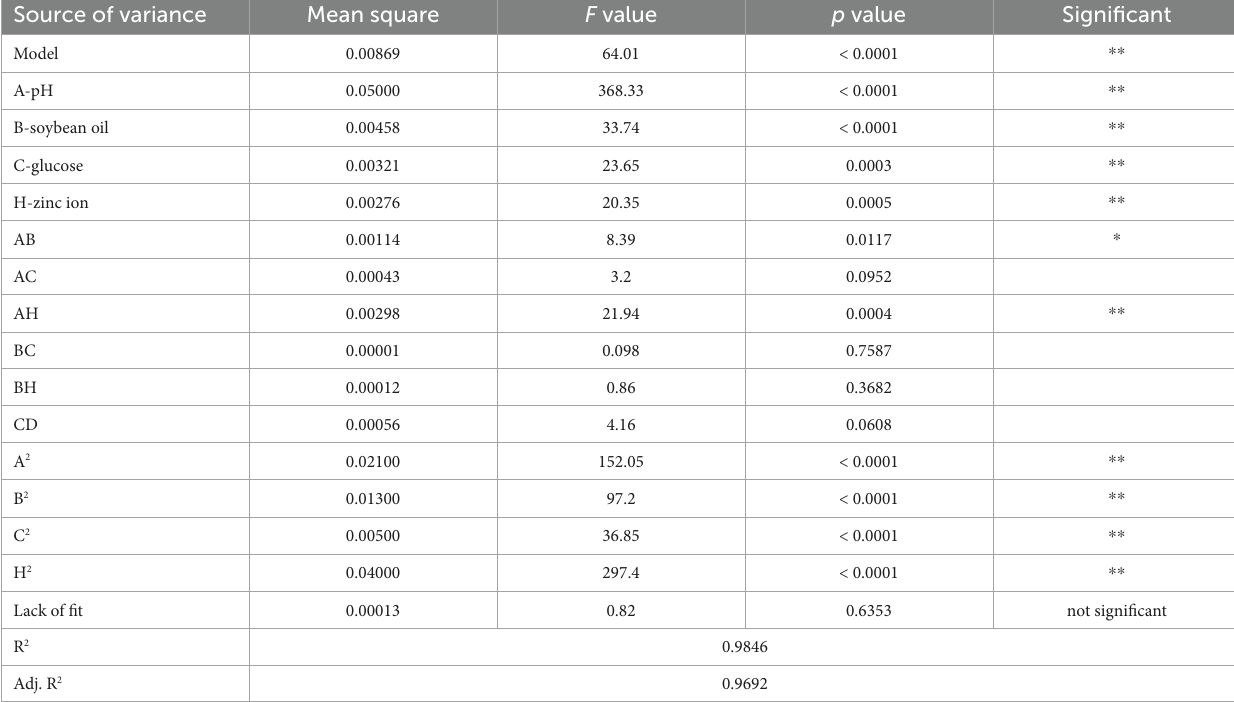
TABLE 6 Variance analysis of the response surface